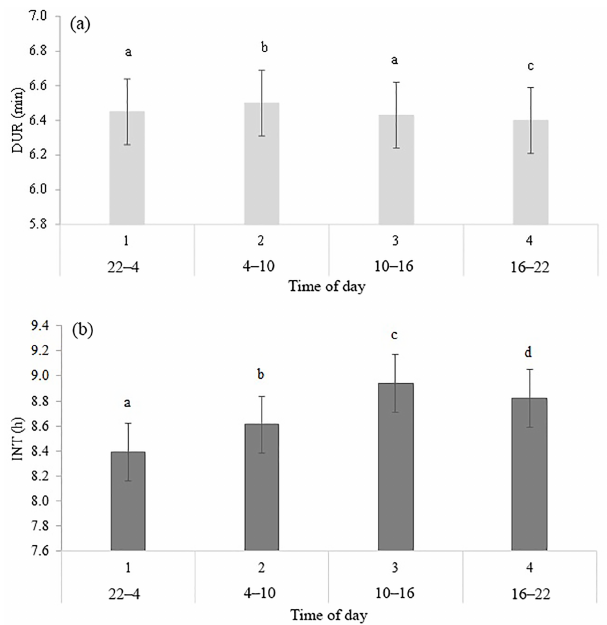
Figure 1. Least squares means for (a) DUR (milking time during a visit in the automatic milking system) ( ± SE) and (b) INT (interval between two consecutive milkings) ( ± SE) with dependency on time of the day in classes. Significant differences of least squares means (<0.05) are indicated with different letters above the bars.